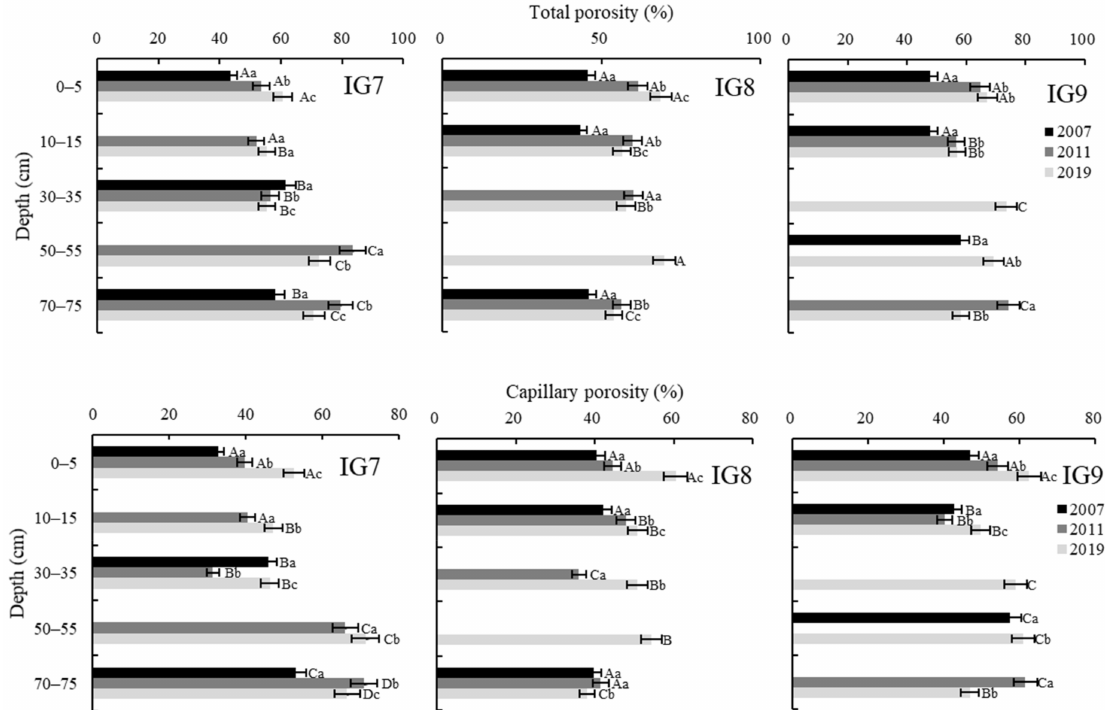
Figure 3. Total porosity and capillary porosity at the different sites; different lowercase letters express significant difference at the same depth (one-way ANOVA, p < 0.05), and different uppercase letters express significant difference under different soil depths (one-way ANOVA, p <